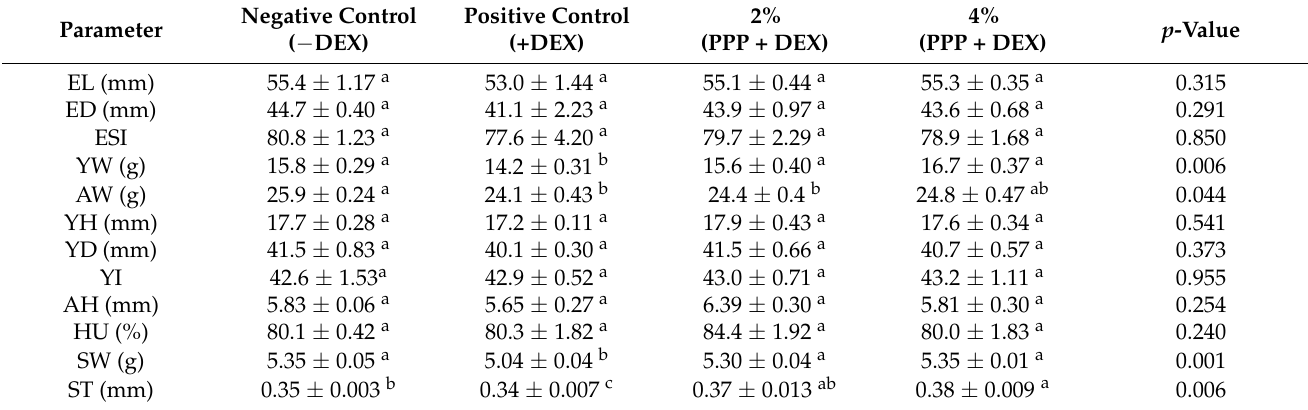
Table 4. Effect of different levels of dietary pomegranate peel on egg quality of laying hens subjected to oxidative stress. Parameter